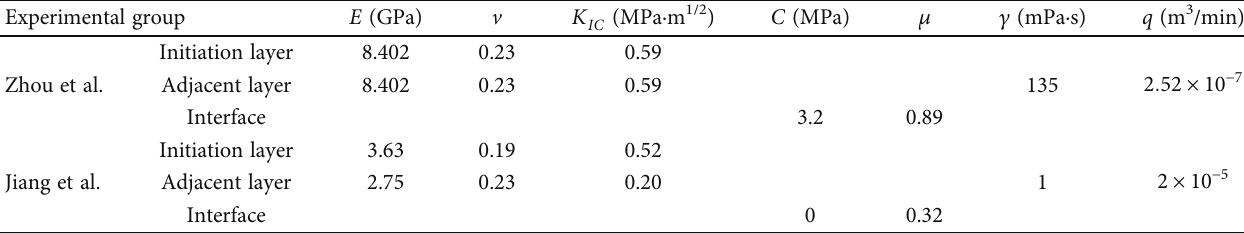
Table 1: Initial experimental parameters of Zhou et al. and Jiang et al.